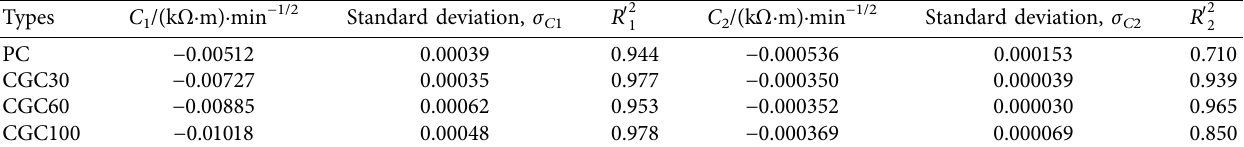
Table 4: Fitting results of the electrical resistivity